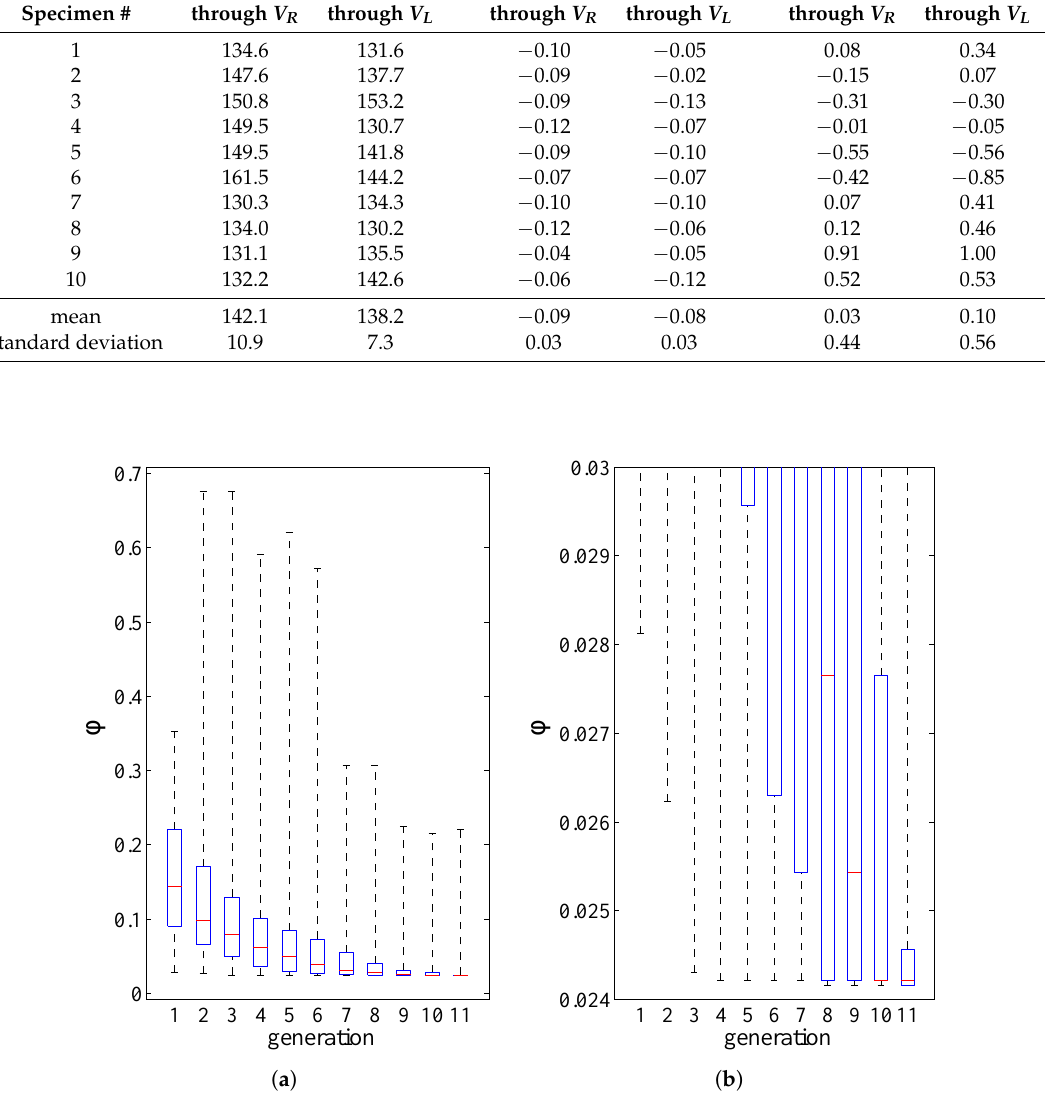
Figure 6. Example of the convergence of the optimal solution provided by the GA at increasing number of generations: ( a ) boxplot showing the spreading of the values of the objective function relevant to all the individuals, and ( b ) close-up near the